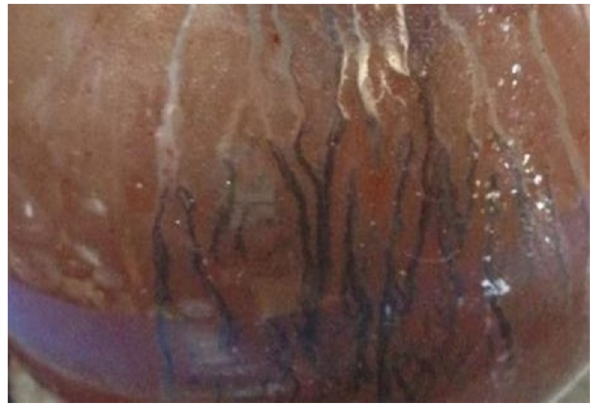
Figure 1: K/KOH/ γ - Al 2 O 3 catalyst with cumene as an